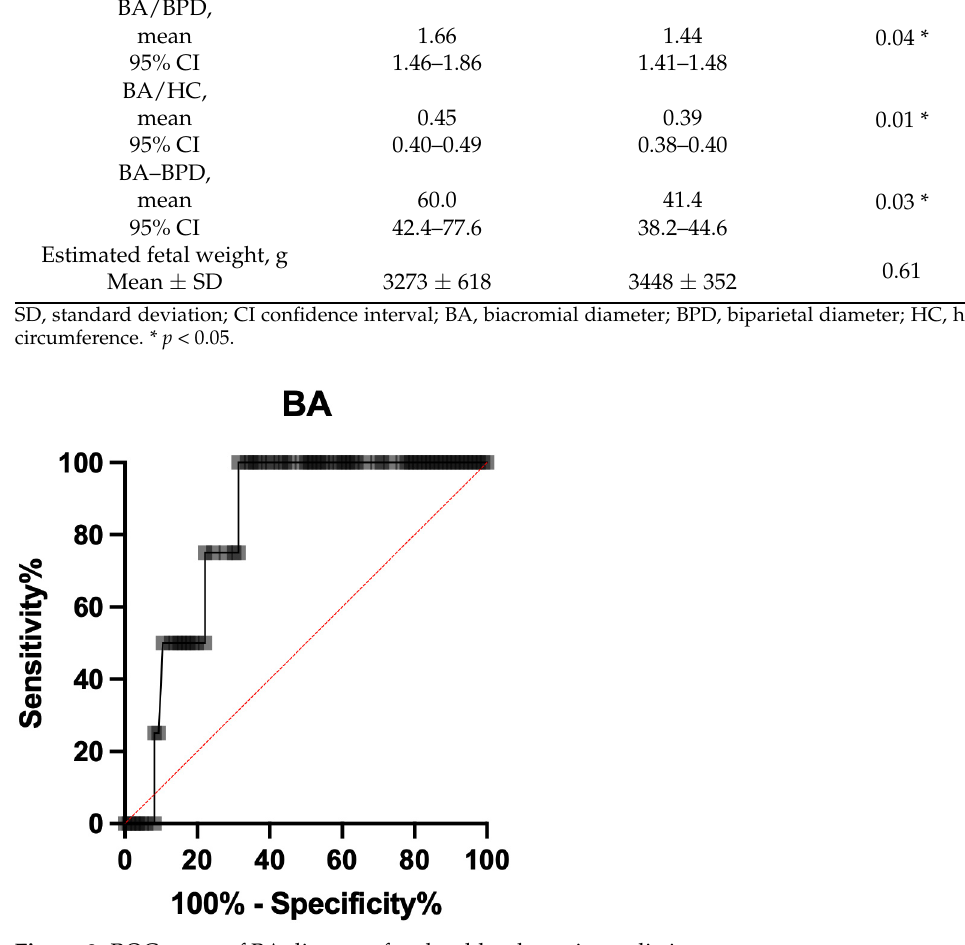
Figure 3. ROC curve of BA diameter for shoulder dystocia prediction.